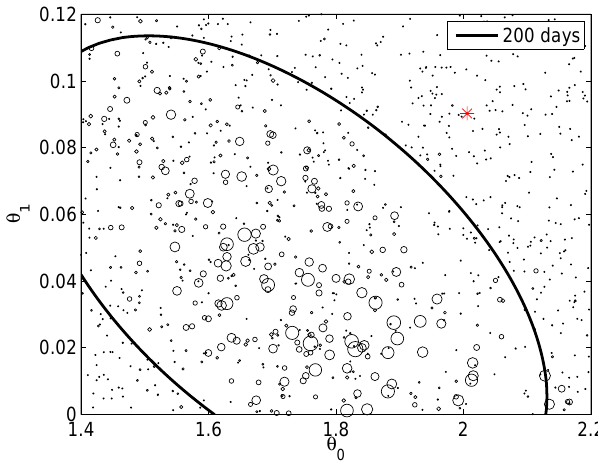
Fig. 2. The scatter plots of the parameter value candidates and their likelihood (represented by the size of the markers) obtained with cost function (39). The marker size reflects the value of the weights for importance sampling. The black ellipse represents the first two moments estimated with importance sampling. The red star repre- sents the parameter values estimated by fitting the forcing model to the simulated fast variables (see Sect. 5 for